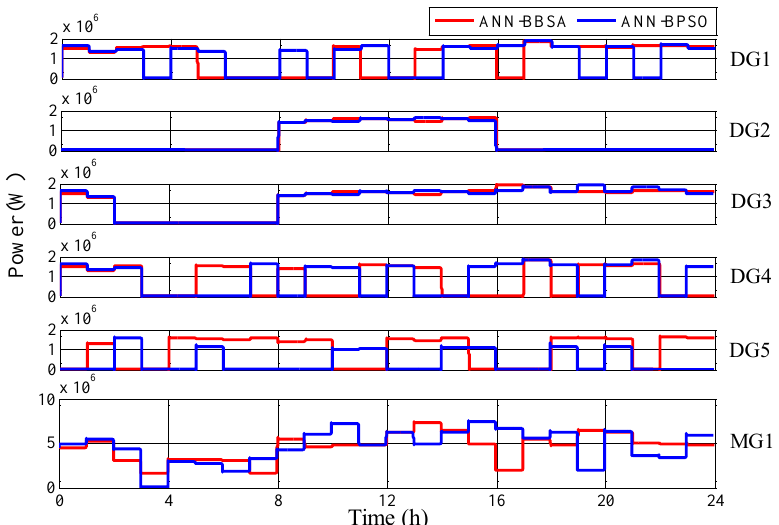
Figure 9. Training data results using the ANN-BBSA and ANN-BPSO tested in the microgrid at bus 5.